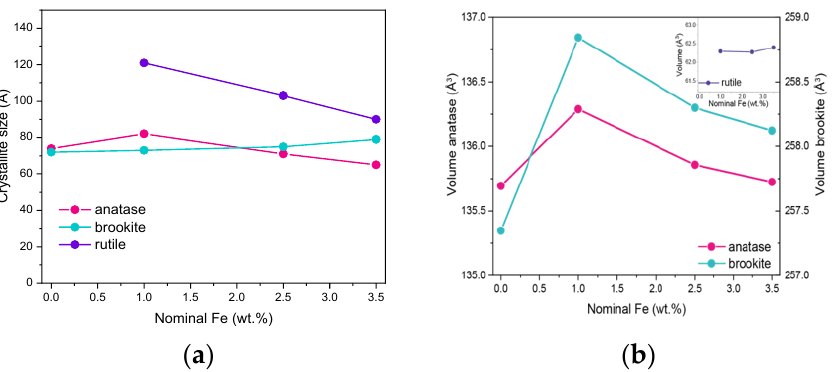
Figure 2. ( a ) Trend of the crystallite size versus the nominal Fe content (wt.%) for anatase, rutile and brookite (s) and trend of the cell volumes of the three polymorphs versus the nominal Fe content (wt.%) ( b ).